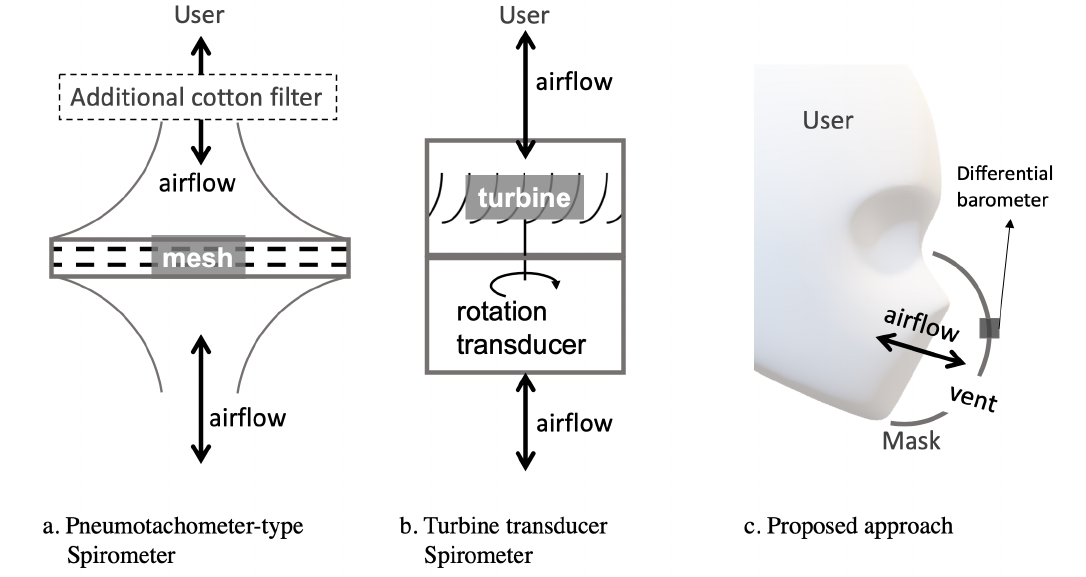
Figure 1. Sensing modality comparisons between current typical mobile spirometers and our approach. ( a ) Pneumotachometer-type and ( b ) turbine-type spirometers all require mechanical parts that